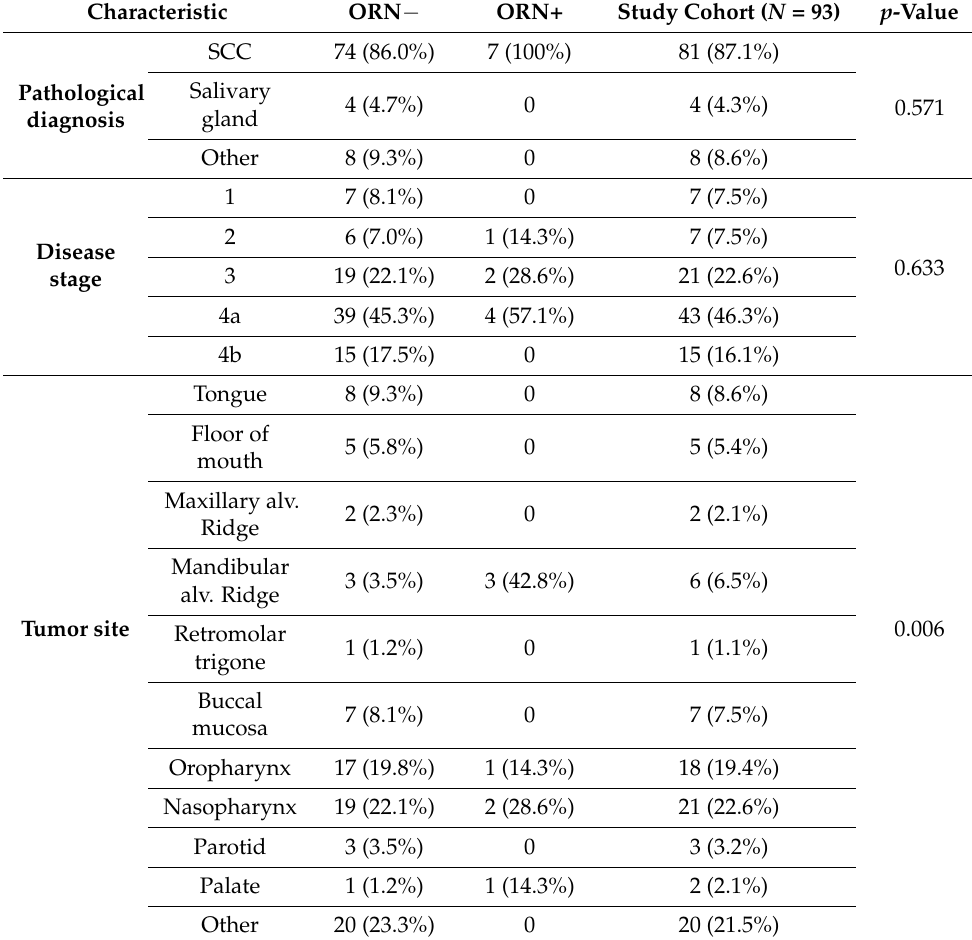
Table 4. Tumor characteristics.